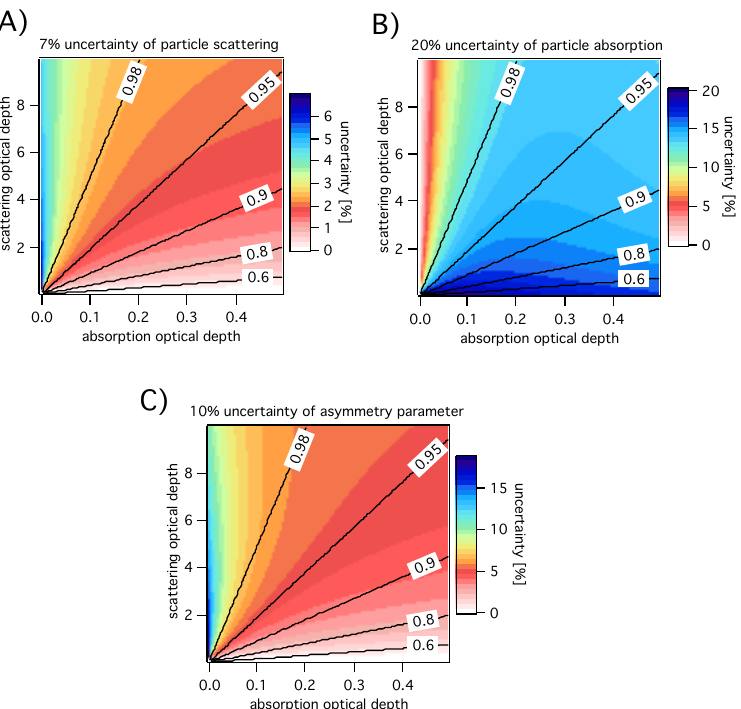
Figure 12. Relative uncertainties in the relative optical depth caused by uncertainties in the particle characterizations: (a) particle scattering, (b) particle absorption, and (c) particle asymmetry parameter. The solid lines indicate constant single-scattering albedos.